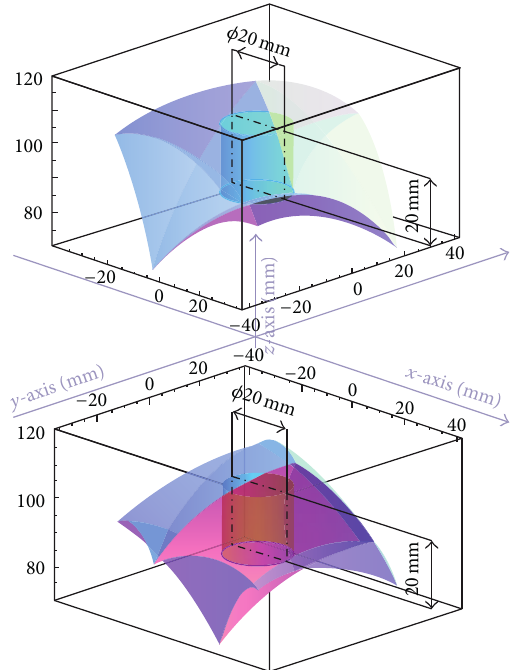
Figure 8: Shape and size of the microrobot’s